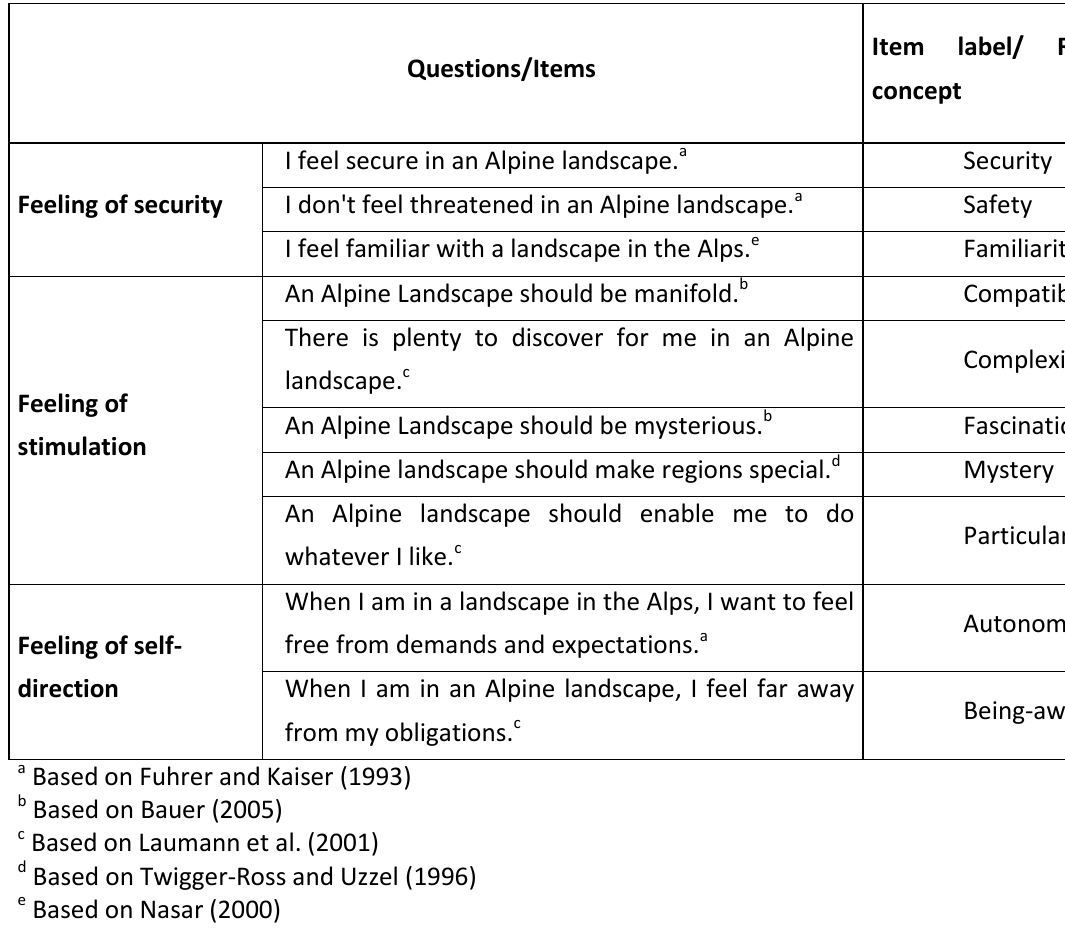
Table 2: The three interrelated factors security, stimulation and self-direction and the corresponding items/questions integrated into the questionnaire and